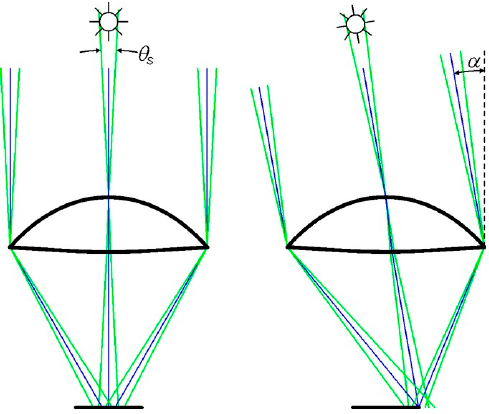
Figure 4. Angular aperture of sunlight θ S and acceptance angle α .